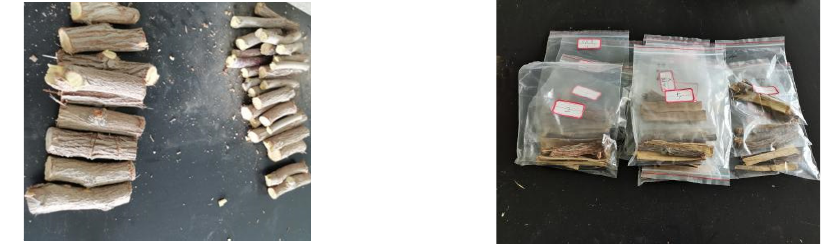
Figure 2. Longitudinal tensile test samples of jujube bark.